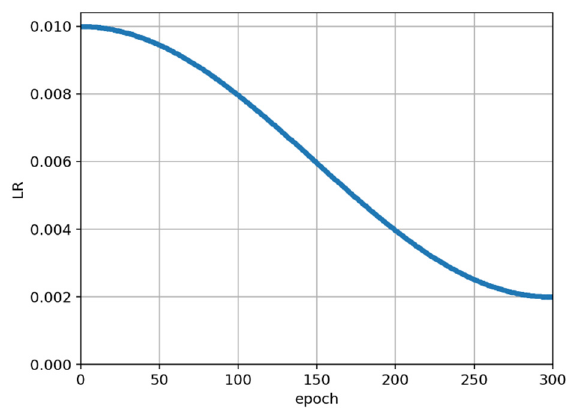
Figure 7. Learning rate strategy for training.